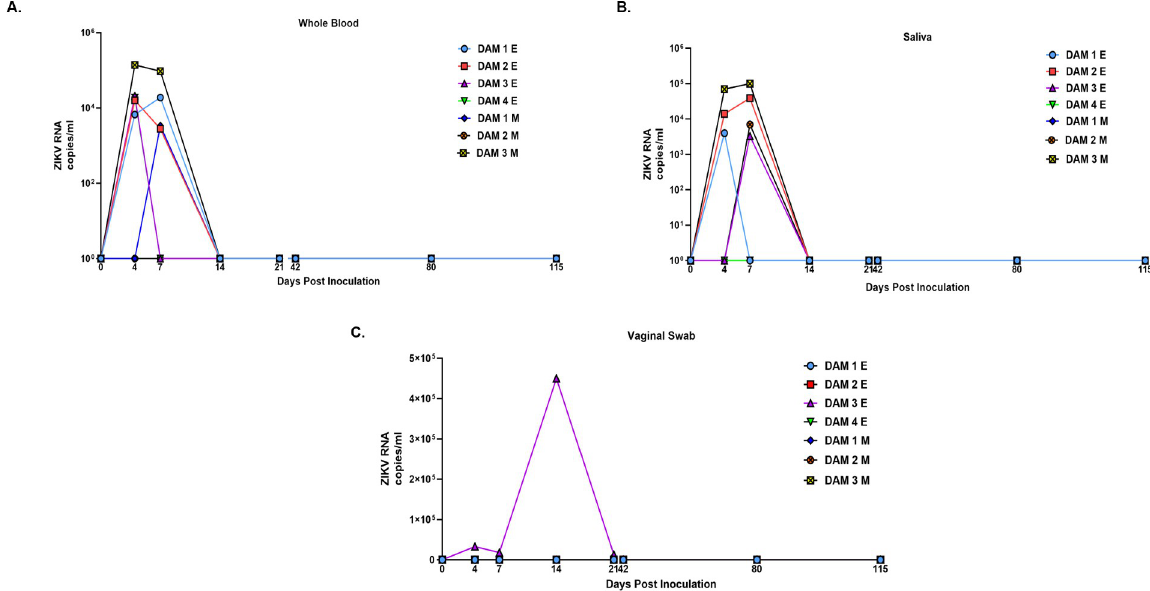
Fig 1. ZIKV RNA (copies per milliliter) in whole blood ( A ), saliva ( B ) and vaginal swab ( C ) samples in baboons inoculated subcutaneously with PR ZIKV isolate during early and mid-gestation. ZIKV RNA was prepared from samples collected from each animal at the indicated days post inoculation and quantitated by one-step